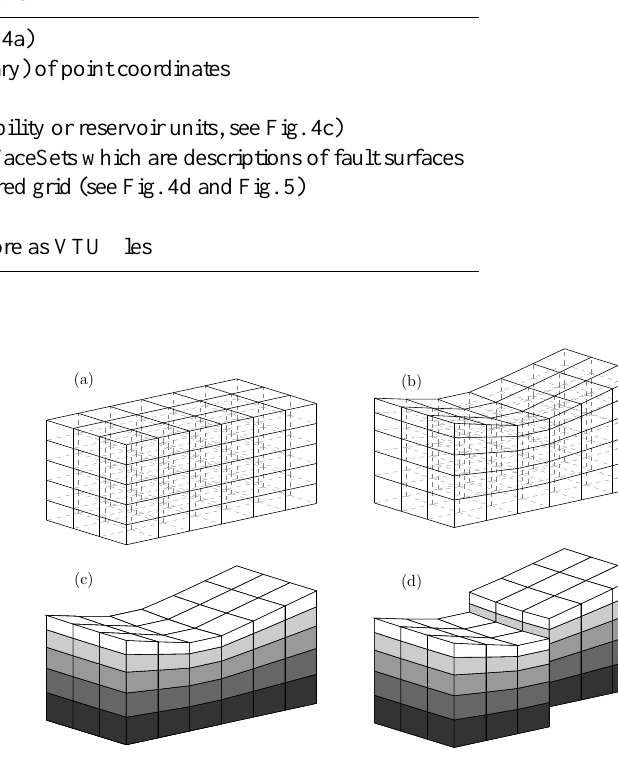
Figure 4. Intermediate results of Algorithm 1: (a) definition of the structured grid, (b) structured grid based on read coordinates, (c) ap- plying flag information, e.g., material groups, and (d) inserted split